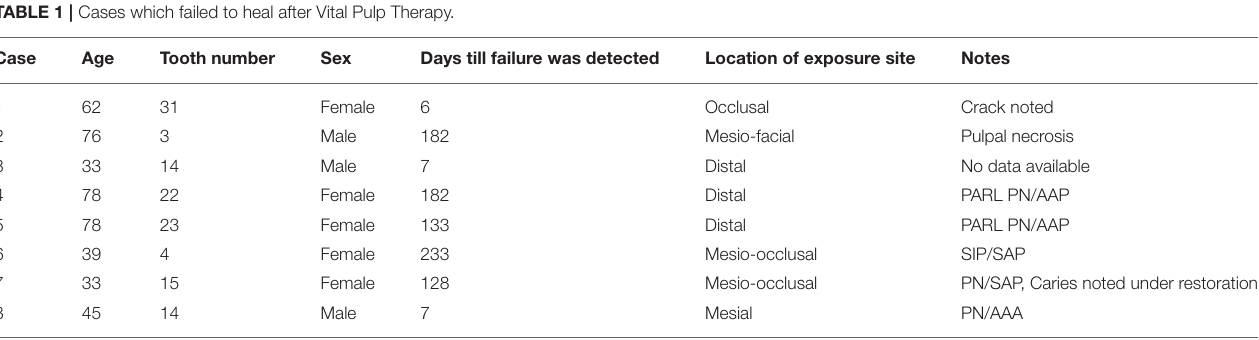
TABLE 1 | Cases which failed to heal after Vital Pulp